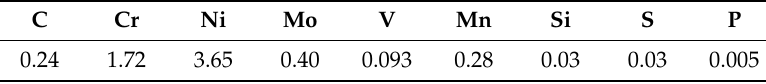
Table 1. The chemical composition of the 30Cr2Ni4MoV steel (wt